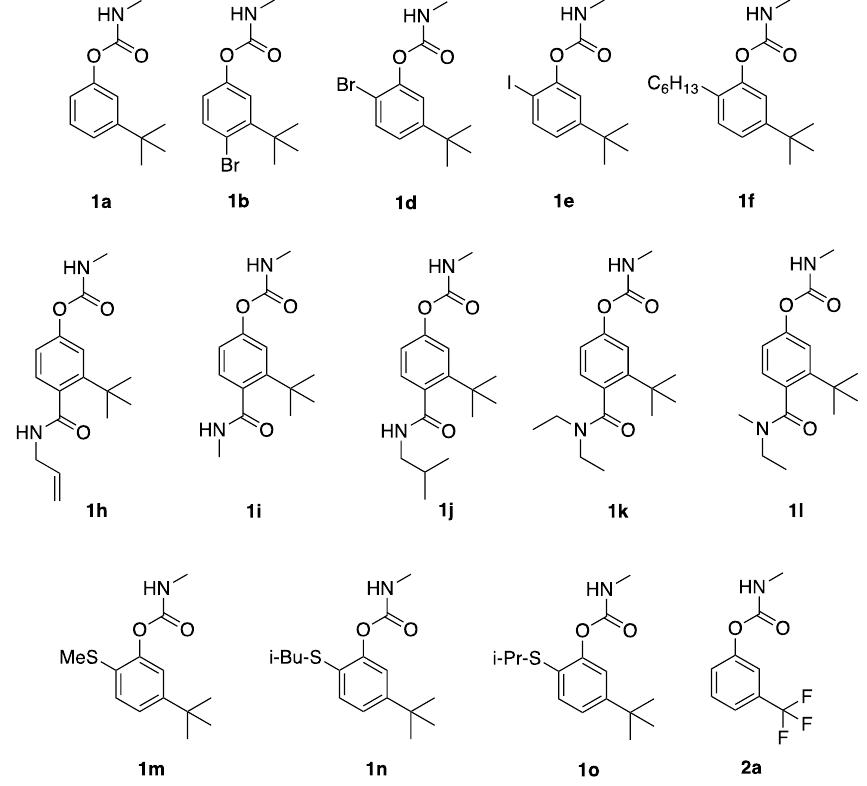
Figure 1. Terbam ( 1a ) and structural analogs described in this study.